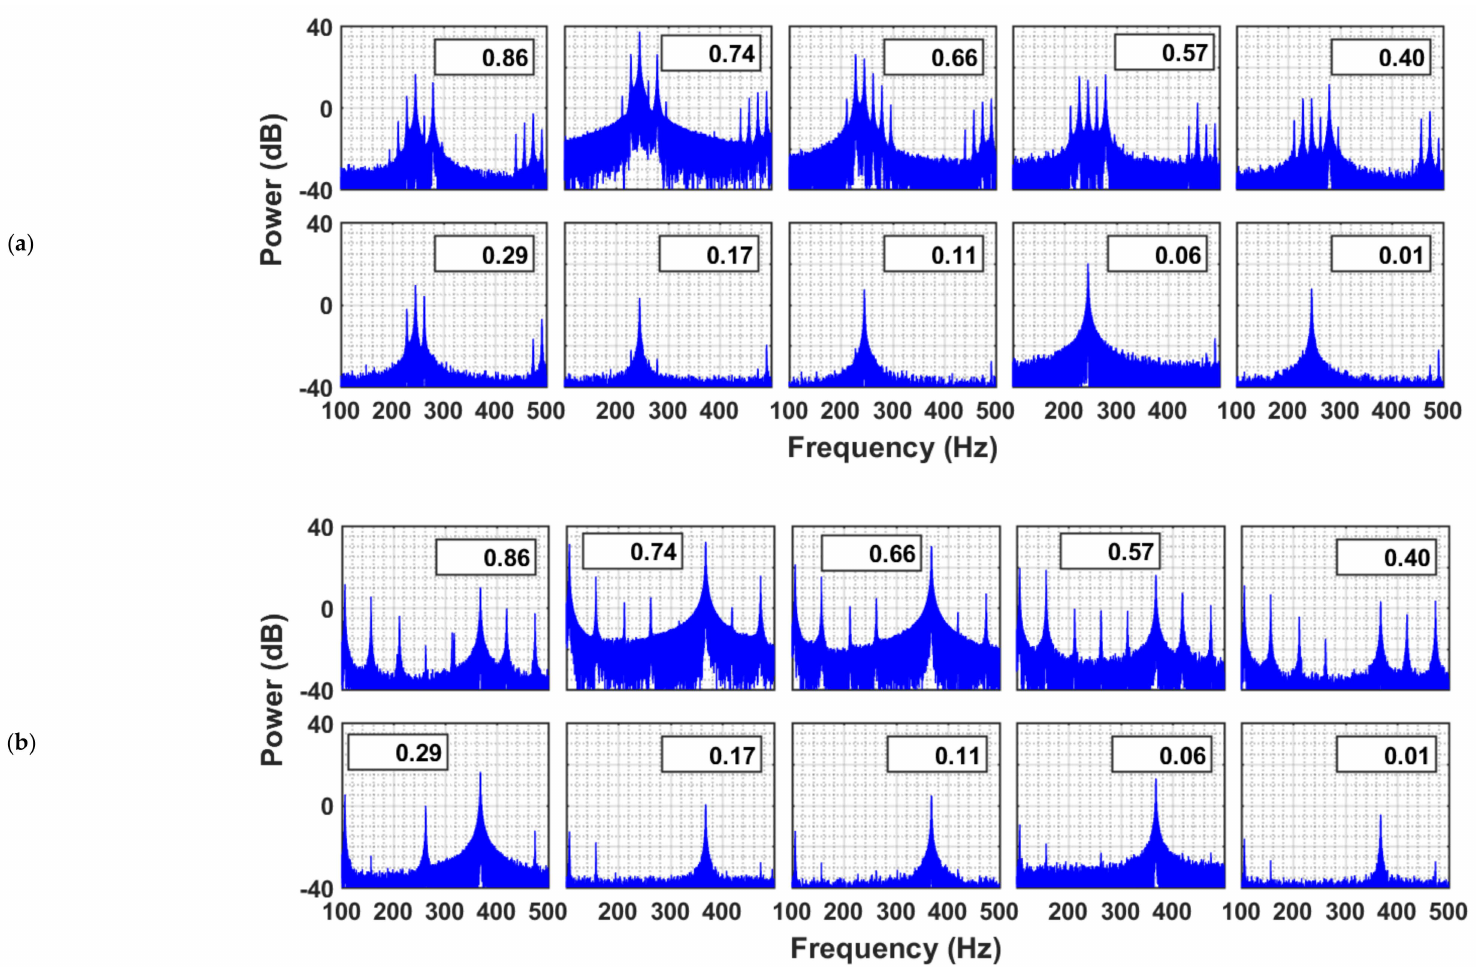
Figure 9. Power spectra of pressure transients in a nanosilica bed and freeboard region excited with sound waves of frequencies ( a ) 240 Hz and ( b ) 360